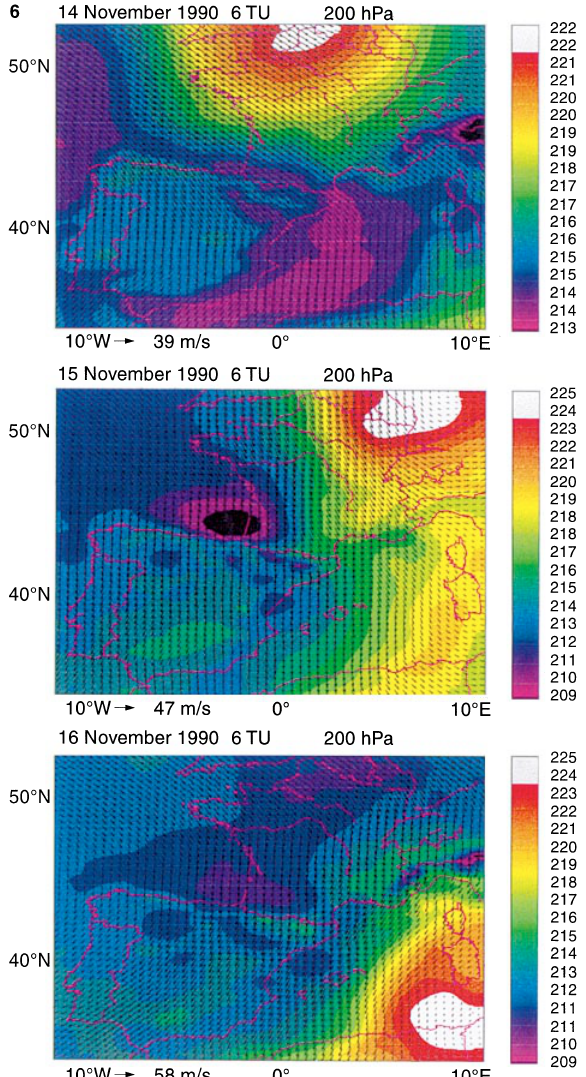
Fig. 6. Same as Fig. 5 but at 200 hPa